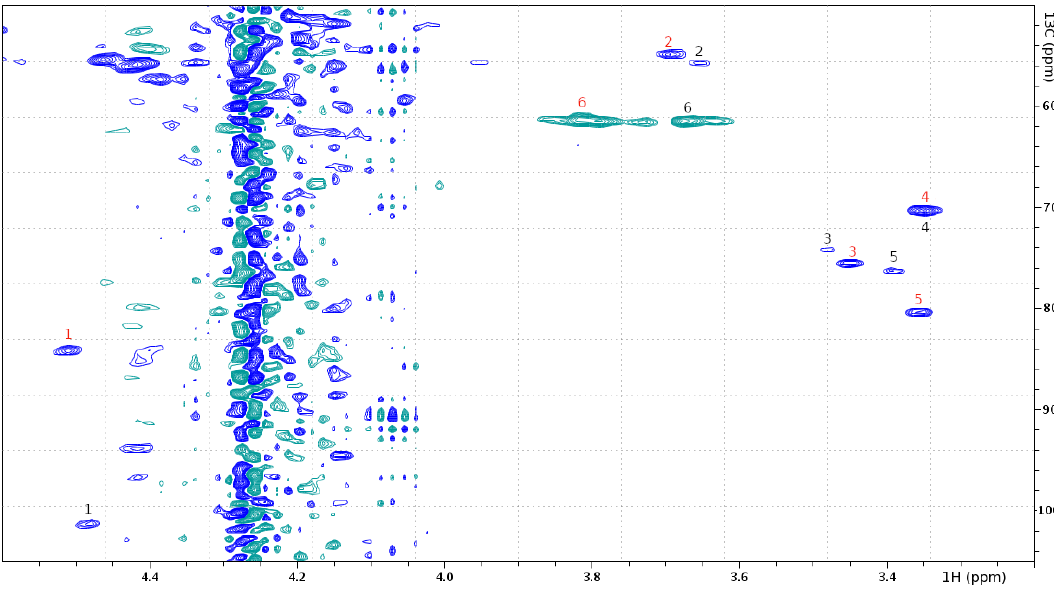
Figure 5. 1 H- 13 C HSQC spectrum shows assignments of the GlcNAc attached to Ser-18 (black) and the